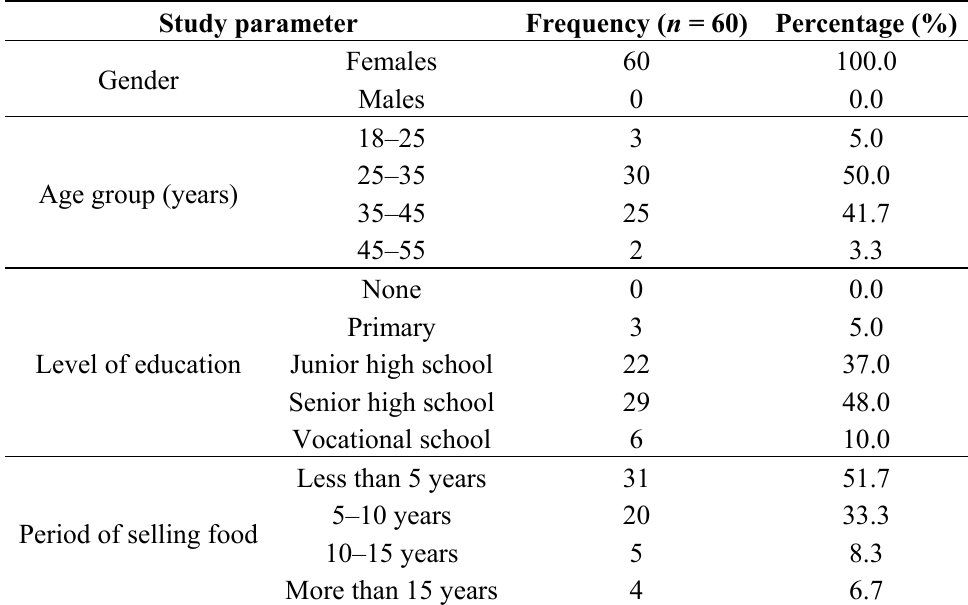
Table 1. Characteristics of respondents.